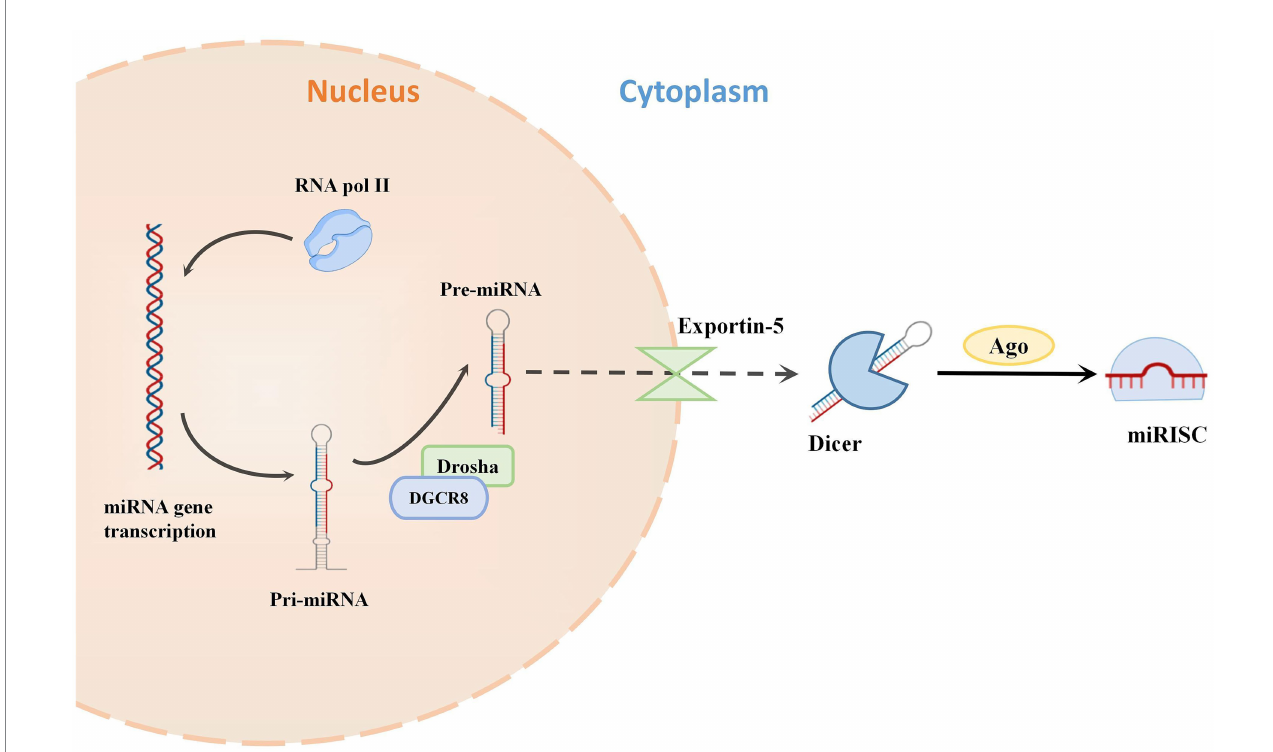
FIGURE 1 The classical bioformation process of miRNA. miRNAs are typically transcribed as primary miRNAs (pri-miRNAs) by RNA polymerase II (Pol II). The microprocessor complex, composed of the RNase III enzyme Drosha and the double-stranded RNA (dsRNA)-binding protein (dsRBP) DiGeorge critical region 8 (DGCR8), cleaves the pri-miRNA and releases a precursor miRNA (pre-miRNA). The export receptor exportin 5 binds pre-miRNAs and aids their export into the cytoplasm. Then the RNase III endonuclease DICER cleaves the pre-miRNA to release double-stranded miRNA. This miRNA is cleaved by Argonaute (Ago) to form the miRNA-induced silencing complex